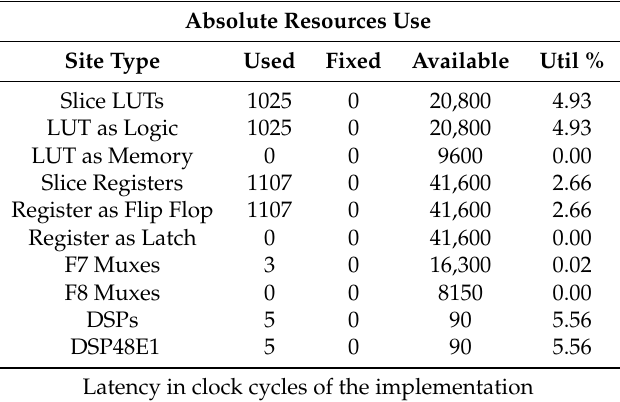
Table 8. Absolute use of FPGA resources.